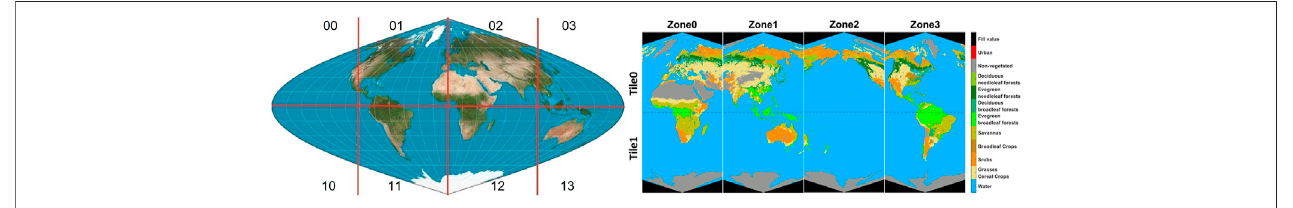
FIGURE1|(left) GlobalSinusoidalprojectioninv1MAIAC,and (right) RotatedSinusoidalprojectionwithgloballandcovertypesinv2MAIACEPICalgorithm.Also shown are the respective tiling